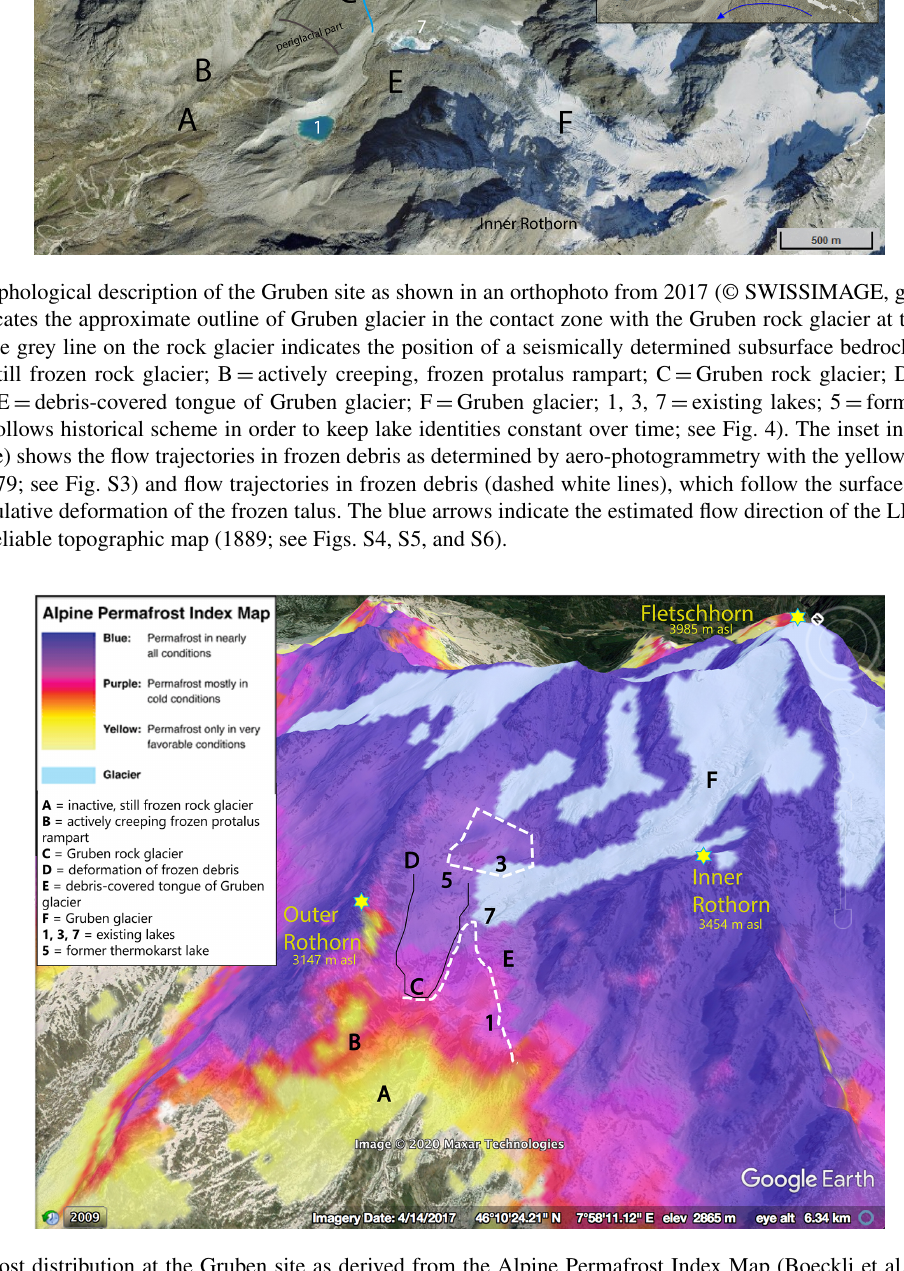
Figure 2. Permafrost distribution at the Gruben site as derived from the Alpine Permafrost Index Map (Boeckli et al., 2012), overlaid on GoogleEarth (© Google Earth 2009; see Figs. S7 and S8 for comparison with other spatial permafrost simulations at the site). The thin black line indicates the outline of the rock glacier. Dashed white lines indicate transition to permafrost-free terrain as documented by BTS measurements and geophysical soundings (see Fig.